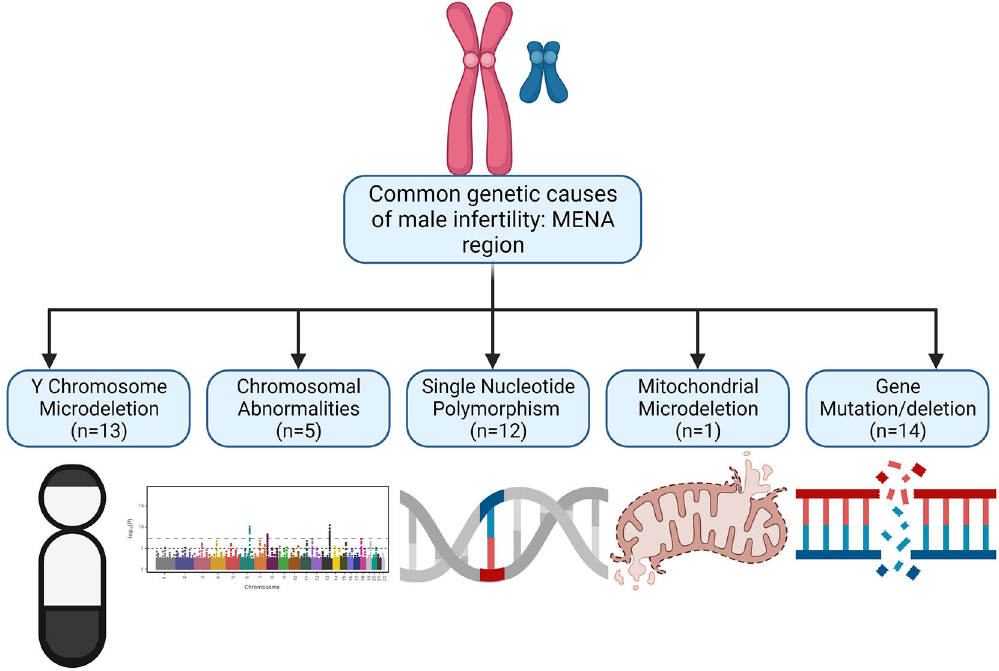
Figure 2. Distribution of MENA studies according to the genetic alteration. From our findings, the following are the common genetic abnormalities found in the MENA region: (i) Y chromosome microdeletion, (ii) deletion or gene mutation, (iii) gene polymorphism or copy number variations, (iv) chromosomal disorders, and (v) mitochondrial mutation.